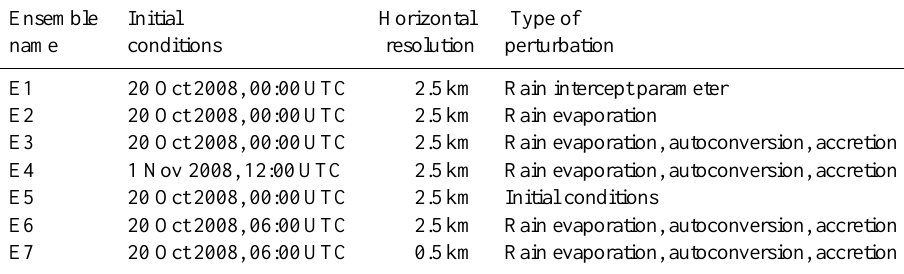
Table 1. Characteristics of the different ensembles Ensemble Initial Horizontal Type of name